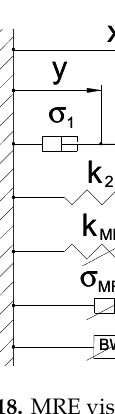
Figure 17. Sample tests for a forcing frequency of 2 Hz with a maximum horizontal force of 200 N: ( a ) current intensity of 0 A, shear stiffness: 330 N/mm at 200 N and 500 N/mm at 700 N; ( b ) current intensity of 6 A, shear stiffness: 600 N/mm at 200 N and 700 N/mm at 700 N.